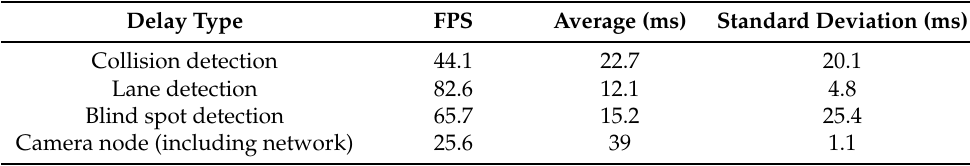
Table 3. Processing times for the proposed